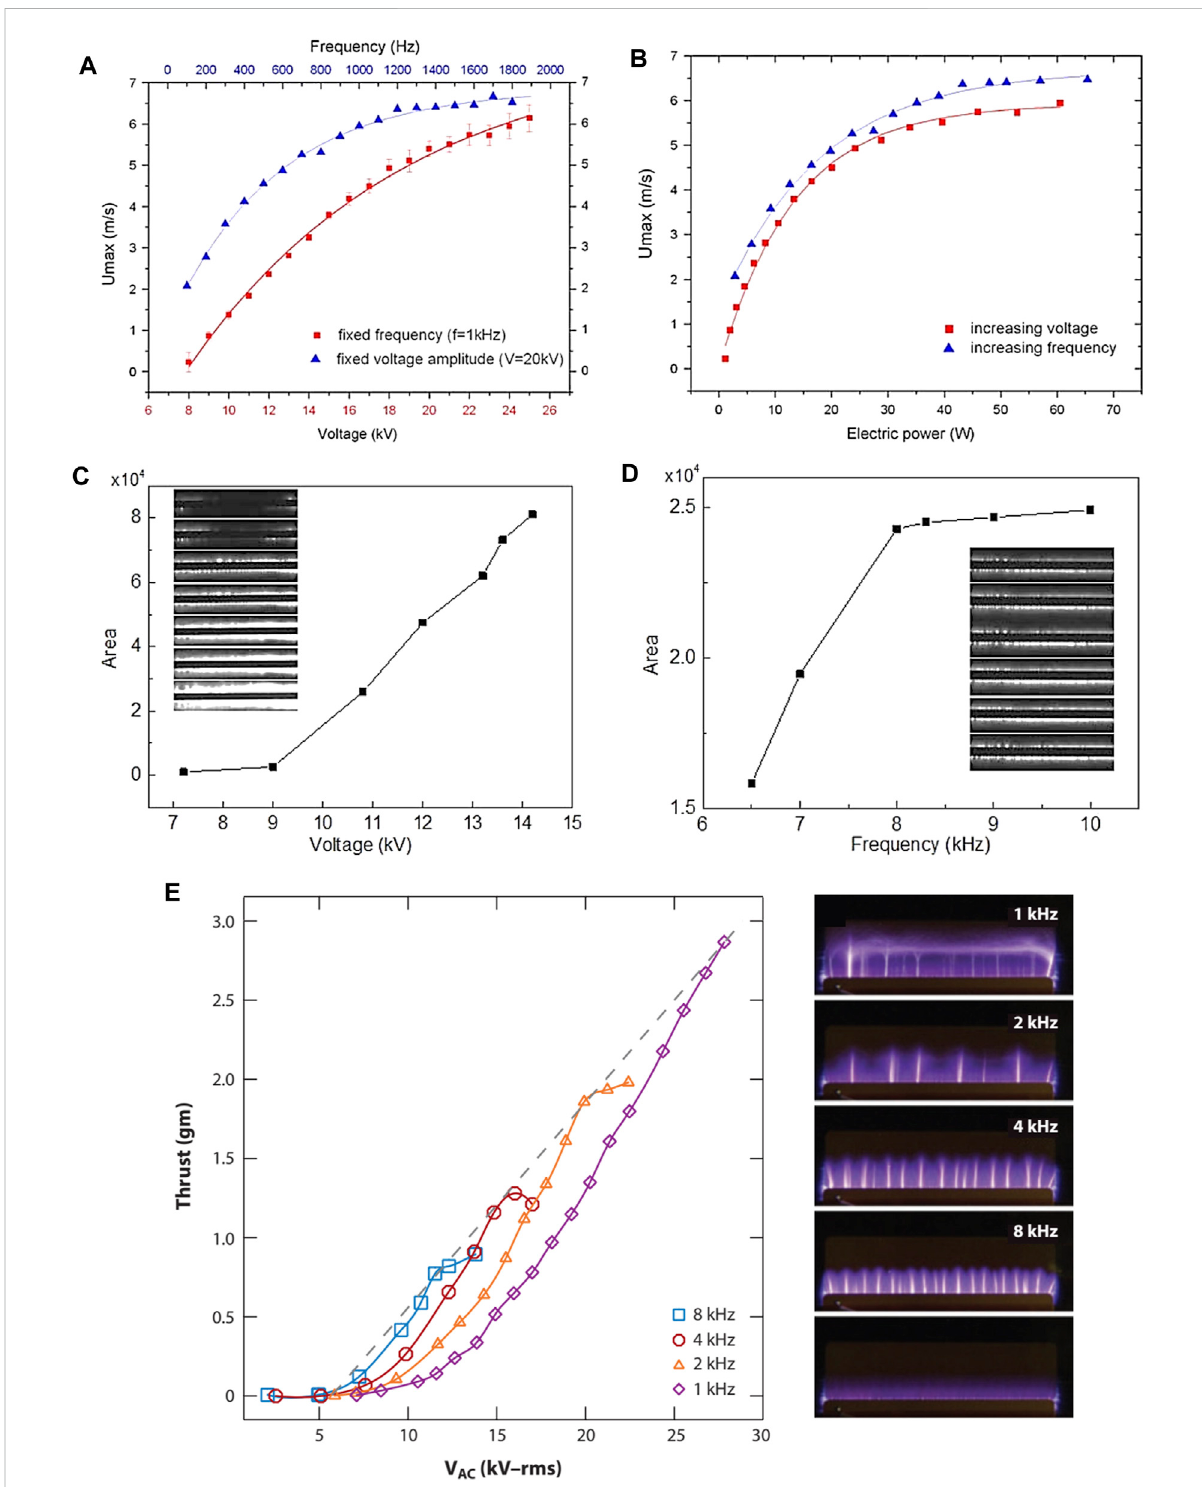
FIGURE 7 (A) Velocity as afunction ofvoltage and frequency. (B) Velocity as a function of electrical power [52]. (C) Discharge areaas afunction of applied voltage for a fi xed driving frequency of 8.4 kHz, including discharge photographs from 7.2 to 14.2 kVmax (top to bottom). (D) Discharge area as a function of applied frequency for a fi xed driving voltage of 12 kVmax voltage, including discharge photographs from 6.5 to 10 kHz (top to bottom) [71]. (E) Induced trust for different AC frequencies. SDBD reactor with a glass dielectric barrier 6.35-mm-thick